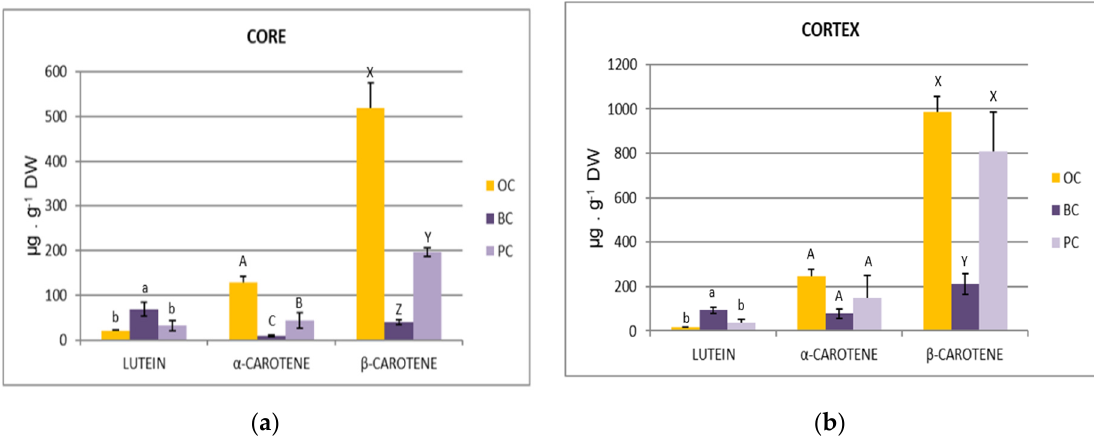
Figure 5. Carotenoid (lutein, α -carotene and β -carotene) contents (µg. g − 1 DW) in the core tissue ( a ) and cortex tissue ( b ) of differently coloured carrots (OC, BC and PC). Data are the means ± SDs ( n = 3). Different letters for each compound group indicate statistically significant differences at p ≤ 0.05.